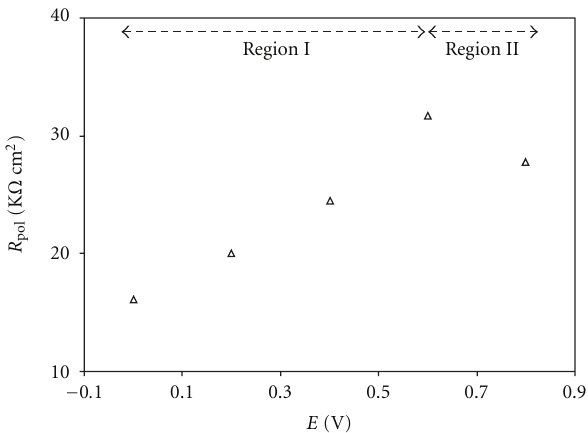
Figure 8: E ff ect of potential on polarization resistance of AISI 321 stainless steel in 0.5MH 2 SO 4